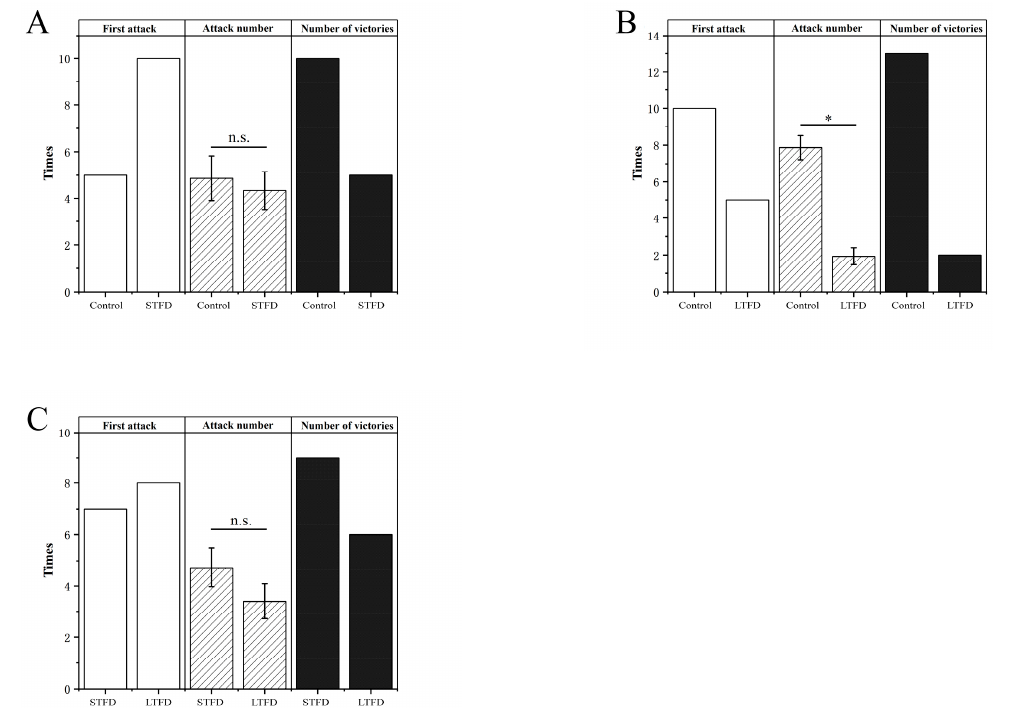
Figure 5. Results of the dyadic fight of black rockfish ( Sebastes schlegelii Hilgendorf, 1880). Half of each group was paired with fish of a similar size from the other two groups (( A ): control group paired with STFD group; ( B ): control group paired with LTFD group; and ( C ): STFD group paired with LTFD group). The first attack, attack number, and number of victories were recorded. Significant differences are indicated by asterisks ( p < 0.05); n.s. ( p > 0.05).